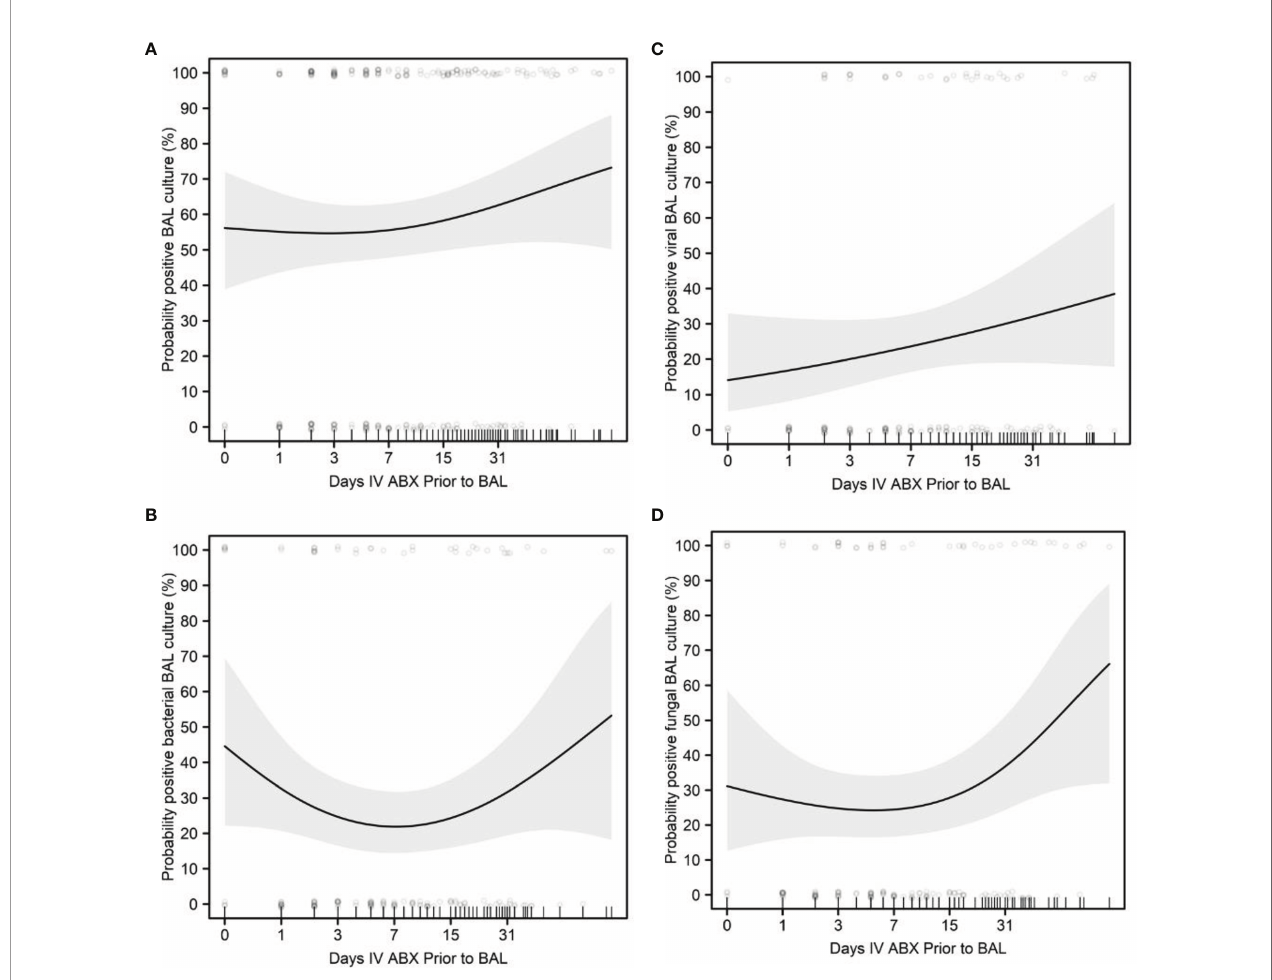
FIGURE 4 | Impact of days of antibiotics and positive BAL cultures. (A) Probability of positive BAL culture. (B) Probability of positive BAL bacterial culture. (C) Probability of positive viral BAL culture. (D) Probability of positive fungal BAL culture. Regression curves are shown as solid lines, bounded by shaded 95% con fi dence intervals. Scatterplots show raw patient measures, jittered slightly for clarity in the probability